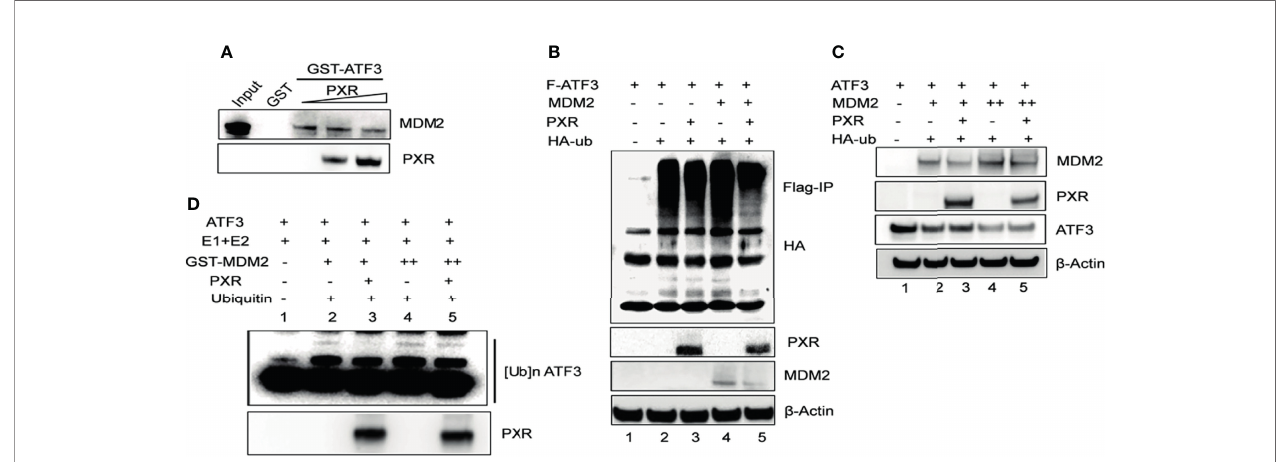
FIGURE 4 | PXR counteracts MDM2-mediated ubiquitination and stabilization of ATF3. (A) PXR disrupted ATF3-MDM2 interaction in vitro . In vitro translated MDM2 and GST-ATF3 were mixed and incubated for 4 h, then 0.5 m g or 1 m g recombinant PXR proteins were added and incubated at 4°C overnight. GST- pulldown assay was performed and the protein levels were determined by Western blotting using indicated antibodies. (B) PXR decreased MDM2-catalysed ubiquitination of ATF3. H1299 cells were transfected with 0.5 m g FLAG-ATF3, 2 m g MDM2, HA-ubiquitin, and/or 3 m g PXR plasmids. After cells were lysed, FLAG-IP assay was performed using FLAG antibody to precipitate and HA antibody to probe. (C) PXR counteracted MDM2-induced downregulation of ATF3. H1299 cells were transfected with 0.2 m g ATF3, 0.8 m g PXR, and increasing amounts of MDM2 (+, 0.8 m g; ++, 1.6 m g) plasmids as indicated, and then lysed for Western blotting. (D) PXR protected ATF3 against MDM2-mediated ubiquitination in vitro . In vitro translated ATF3 incubated with E1, E2, and/or GSTMDM2 (E3) for 2h at 4°C, then mixed with or without 1 m g recombinant PXR protein at 37°C for 2h. The protein levels were determined by Western blotting using indicated